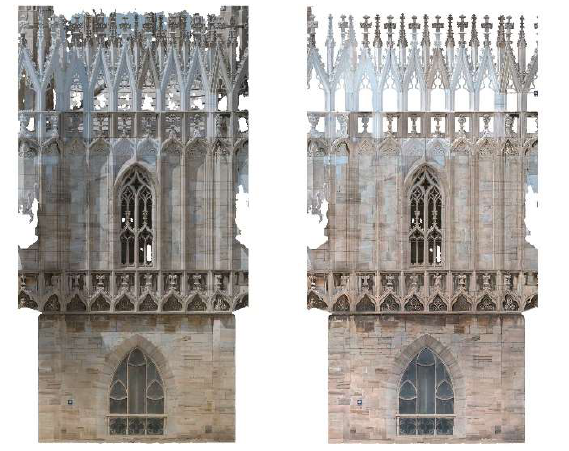
Figure 3. orthophoto of a portion of the South elevation, raw result on the left, and final on the right after the post